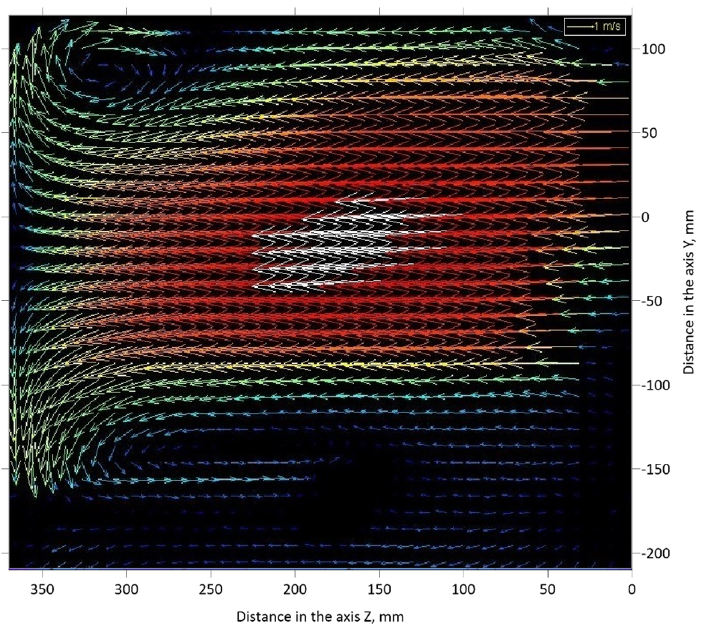
Figure 8. Air velocity vector field in the plenum box at Z-Y plane passing through the center of the spigot.